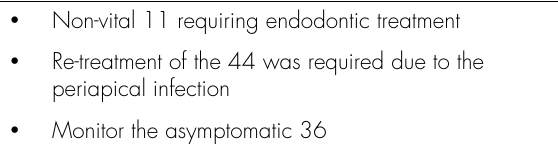
Table Ib. Endodontic diagnostic